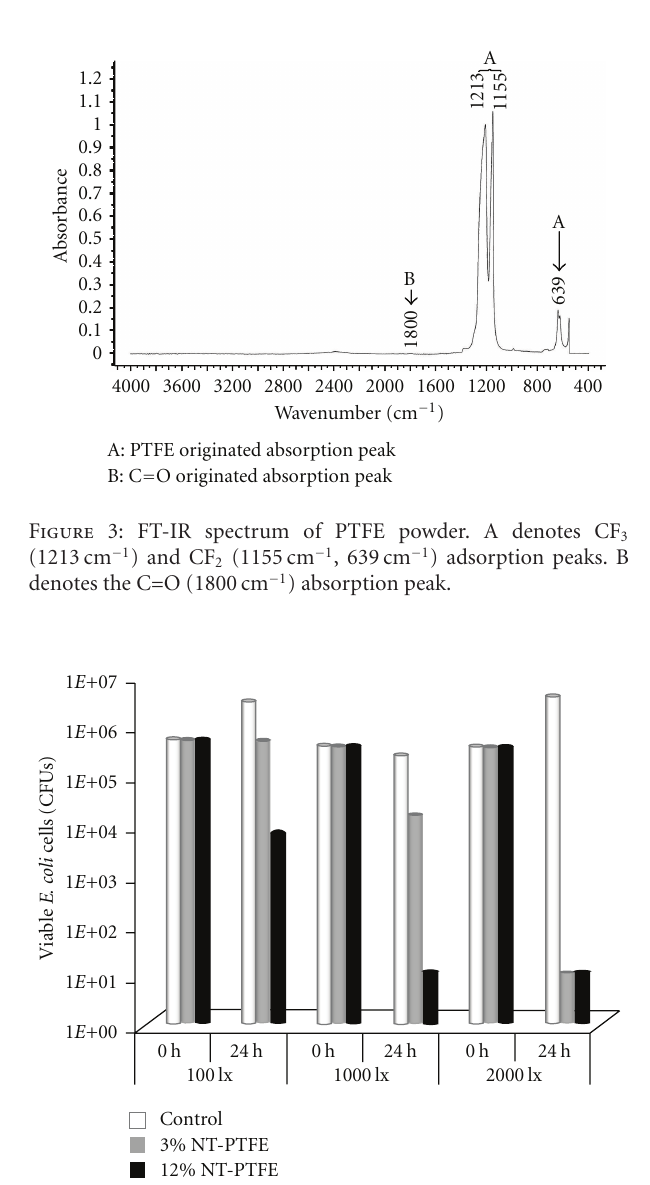
Figure 4: Antibacterial activity of PTFE hydrophobic composite films, without (Control) and with the addition of N-doped TiO 2 (NT-PTFE), on E. coli under visible-light illumination for 24 hours. The e ff ects were dependant on visible-light intensity and the concentration of N-doped TiO 2